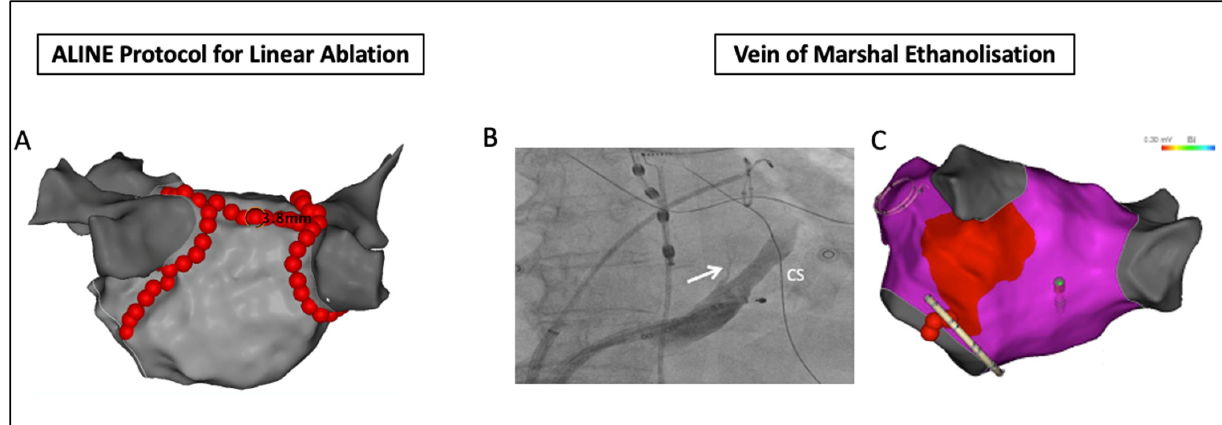
Figure 2. Strategies for substrate ablation in persistent AF. ( A ) Roof and mitral isthmus lines created using optimized RF lesions as per the ALINE protocol. ( B ) Fluoroscopic image of contrast injection of the coronary sinus with the Vein of Marshall indicated by the white arrow. ( C ) Voltage map post ethanolization of the Vein of Marshall demonstrating the resultant area of low voltage and additional endocardial lesions at the mitral annulus performed to achieve mitral isthmus block. CS = coronary sinus.